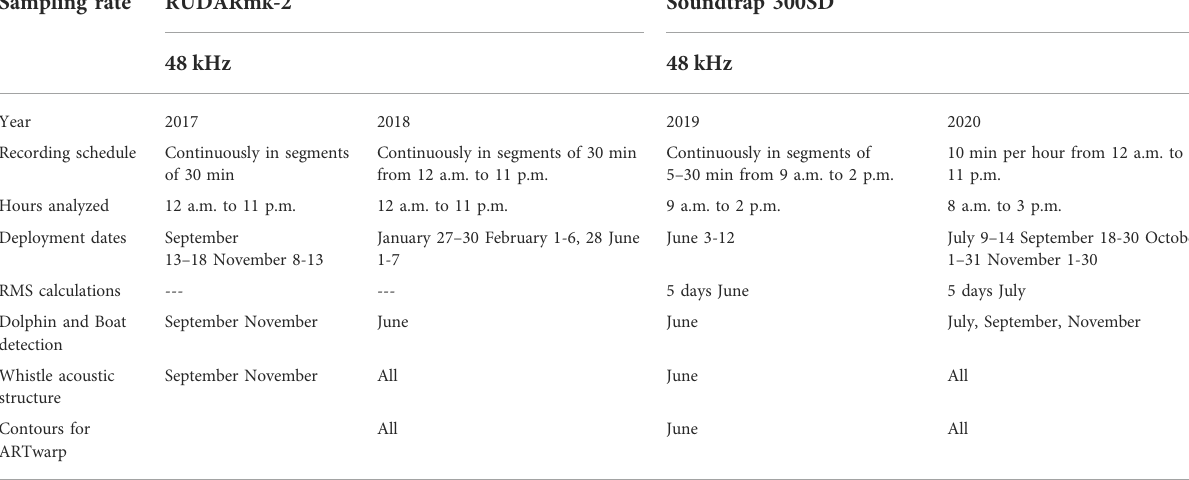
TABLE 1 Summary of recording effort and datasets used for each